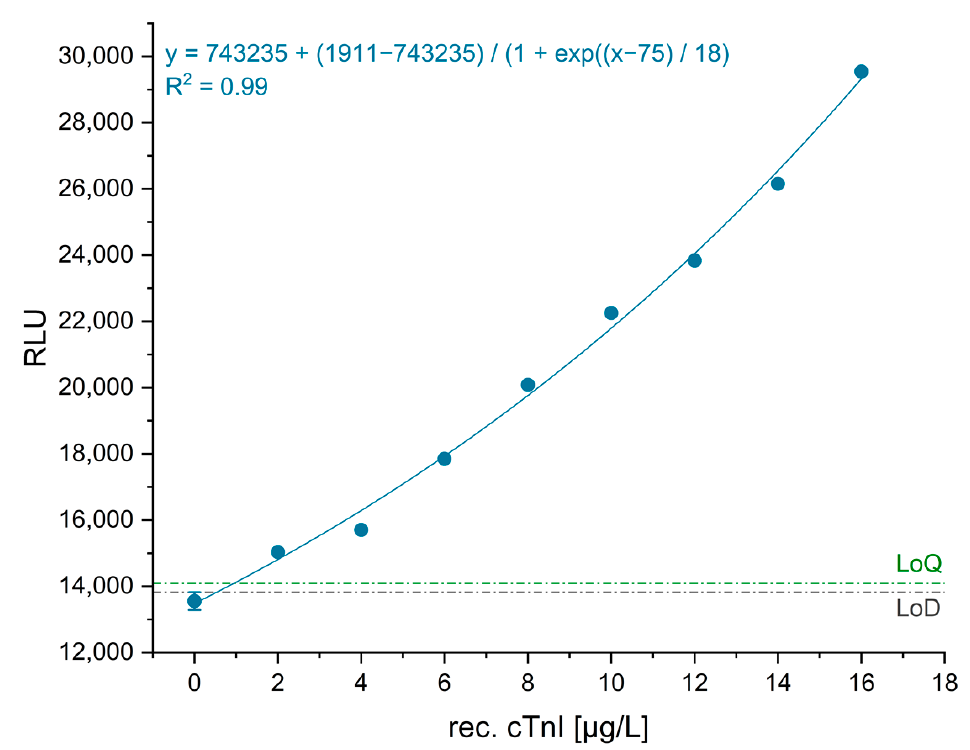
Figure 11. Calibration curve for troponin I in the range of 0 to 16 µg/L and calibration curve after peak integration. The error bar of the blank is shown as 3 standard deviations. The sensor data are shown in Figure S12.